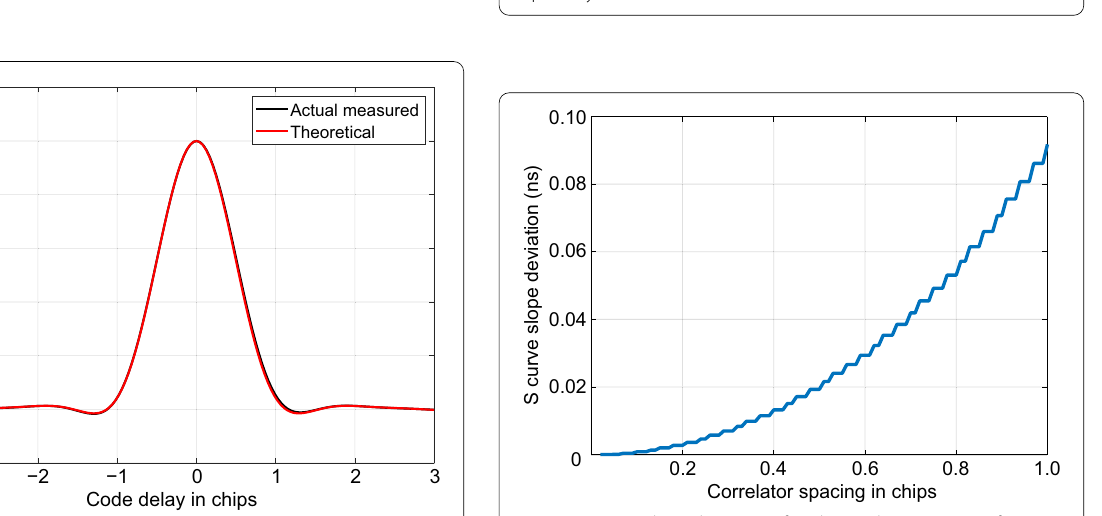
Fig. 15 S curve slope deviation of each signal component of